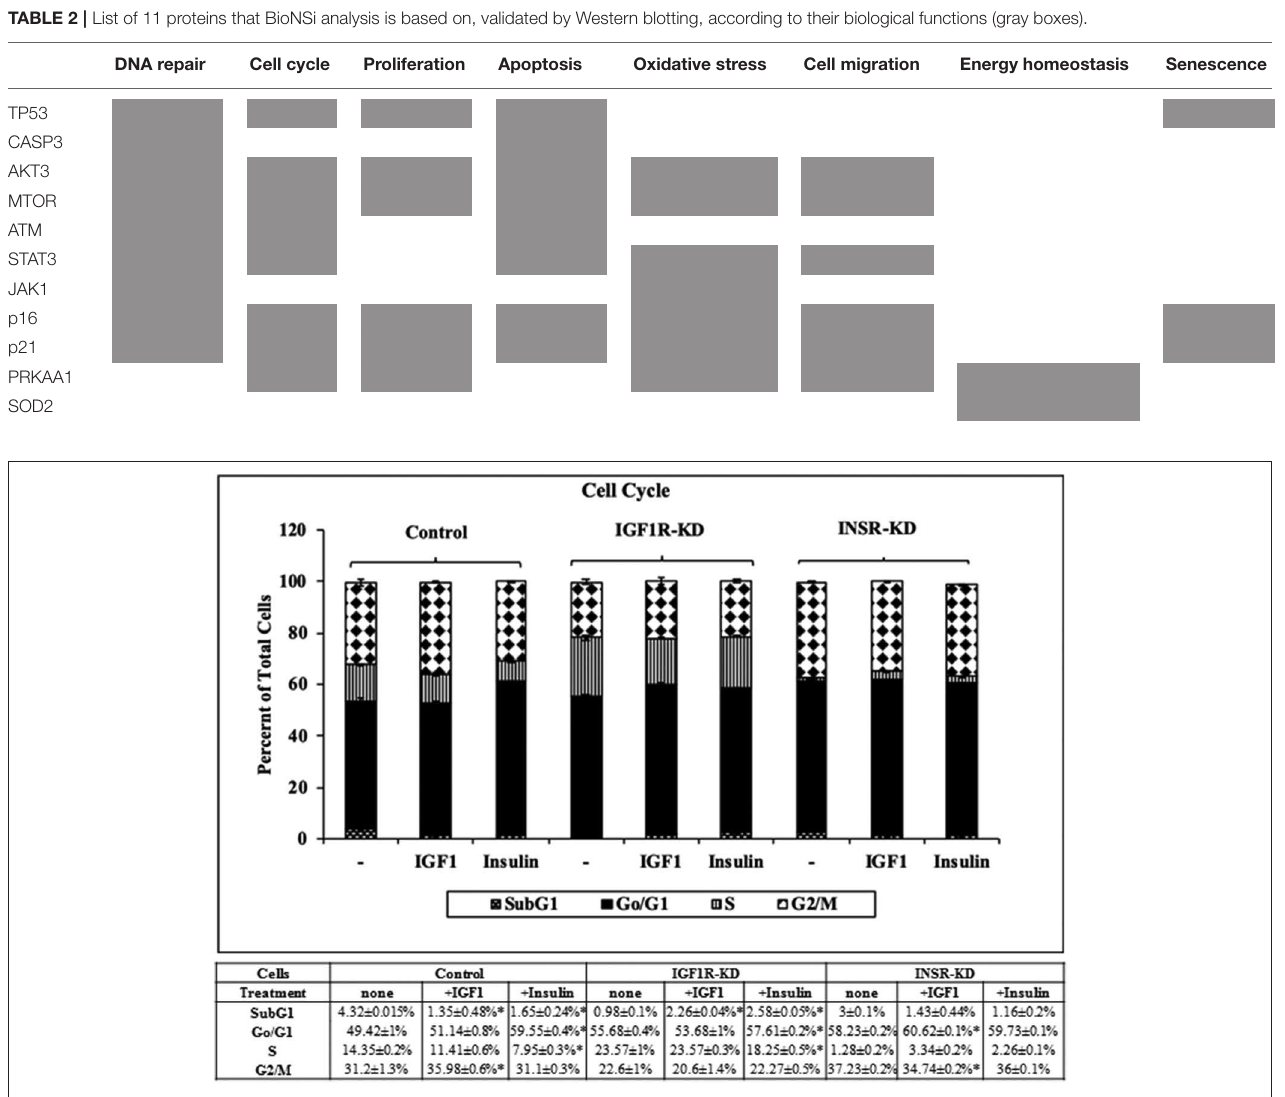
FIGURE 6 | Cell cycle stages distribution in Control, IGF1R-KD, and INSR-KD cells. Cells were seeded in quadruplicate dishes, and treated with IGF1 or insulin (or left untreated, controls) for 72h. The bars represent mean ± SEM) of three independent experiments, performed each in duplicates samples. Cell cycle distribution was measured as described in section Materials and Methods. * p = 0.05 vs. untreated